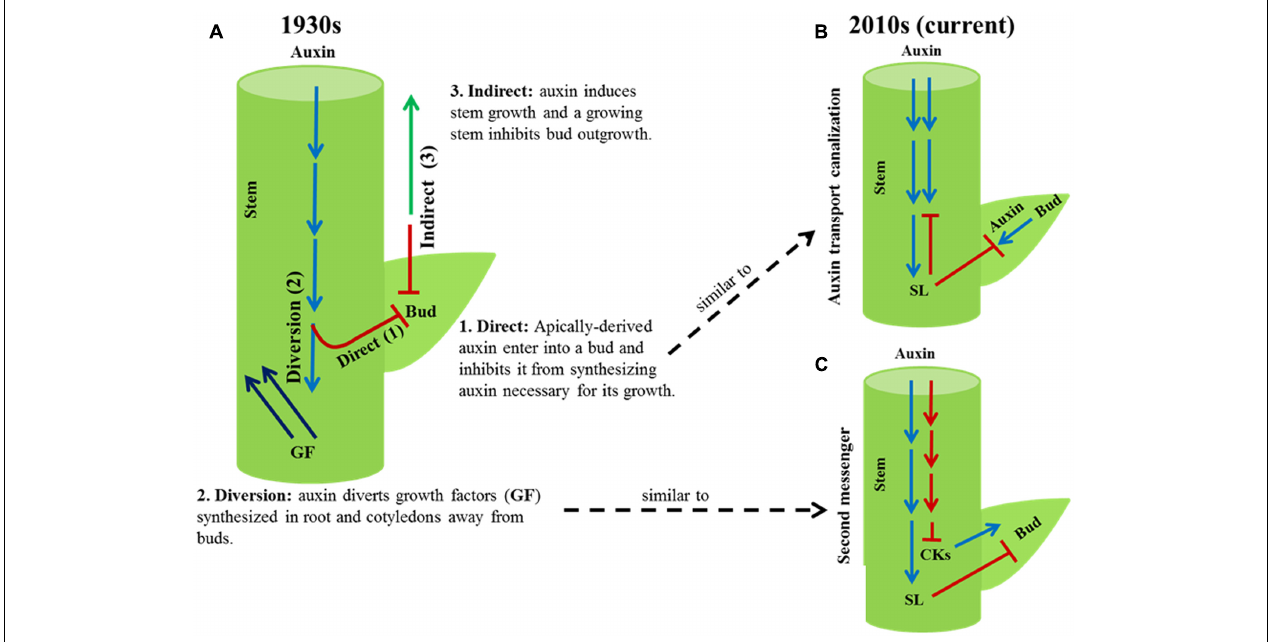
FIGURE 1 | Old and current theories of apical dominance. (A) Three theories, direct (1), diversion (2) and indirect (3), were proposed in the 1930s to explain how auxin from the shoot apex might inhibit axillary bud outgrowth. The direct and diversion theories were investigated in detail and are now replaced with the current auxin transport canalization (B) and second messenger (C) theories, respectively. The indirect theory of the 1930s has been generally overlooked.